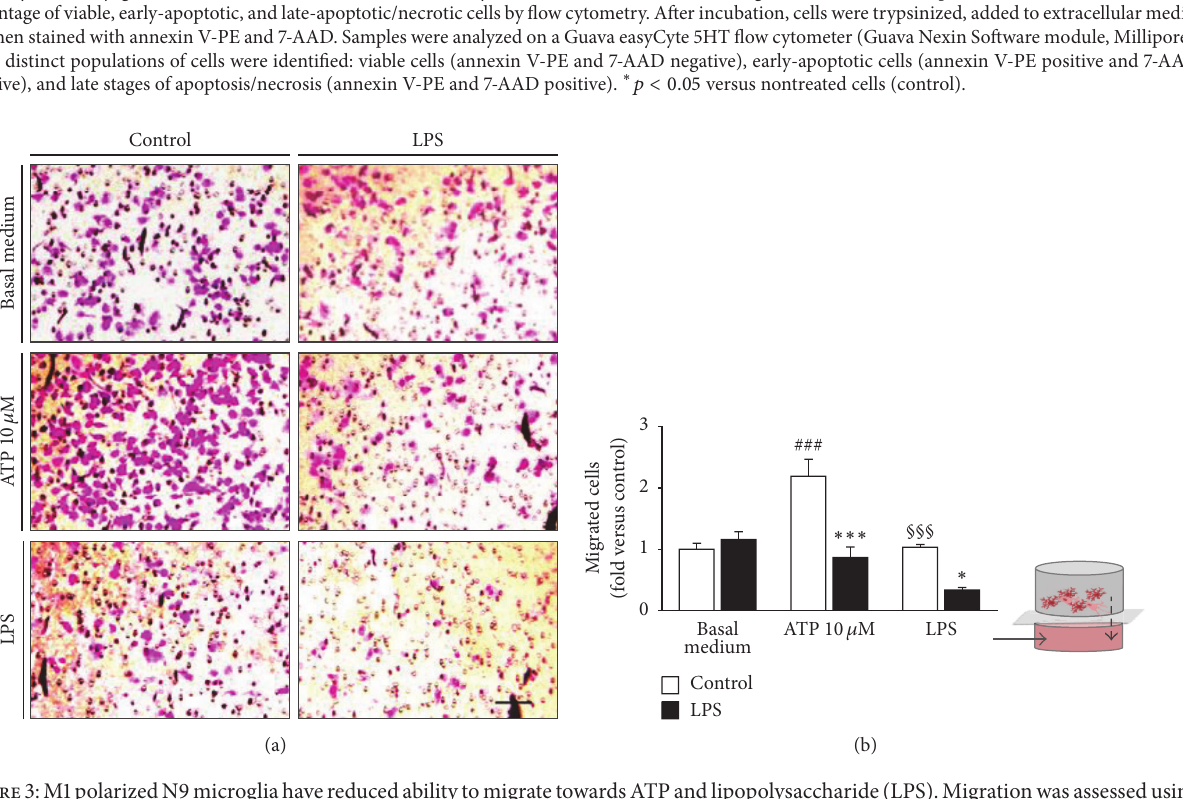
Figure3:M1polarizedN9microgliahavereducedabilitytomigratetowardsATPandlipopolysaccharide(LPS).Migrationwasassessedusing a Boyden Chamber. Nontreated (control) and LPS-stimulated microglia were allowed to migrate for 6 h to basal medium (basal migration), ATP at 10 𝜇 M and LPS at 300 ng/mL. Representative results of one experiment are shown (a). The total number of cells per well was counted and the results were expressed as fold versus control (basal migration) (b). Results are mean ± s.e.m. from four independent experiments. Comparison was done by one-way ANOVA followed by multiple comparisons Bonferroni post hoc correction. ∗ 𝑝 < 0.05 and ∗∗∗ 𝑝 < 0.001 versus respective control; ### 𝑝 < 0.001 versus basal migration in controls; and §§§ 𝑝 < 0.001 versus migration of control cells to ATP. Scale bar represents 100 𝜇